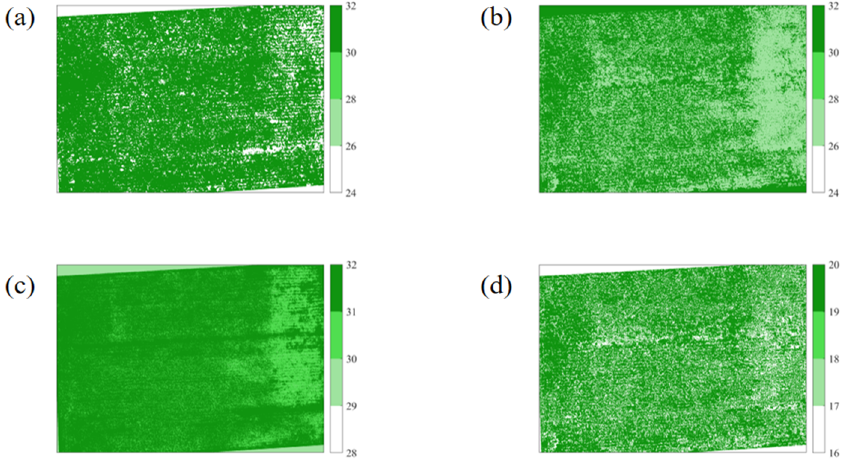
Figure 8. The ML-based yields prediction of maize using the scale-up method. Note: ( a ), ( b ), ( c ), and ( d ) represent the results using BP, SVM, RF, and ELM, respectively.